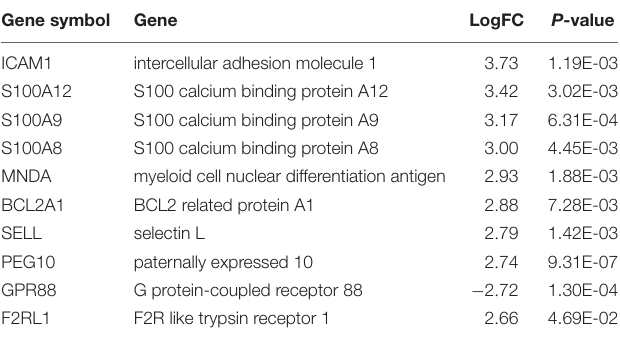
TABLE 1 | Top 10 differential genes in both steatosis vs. Control and NASH vs. Control. Gene symbol